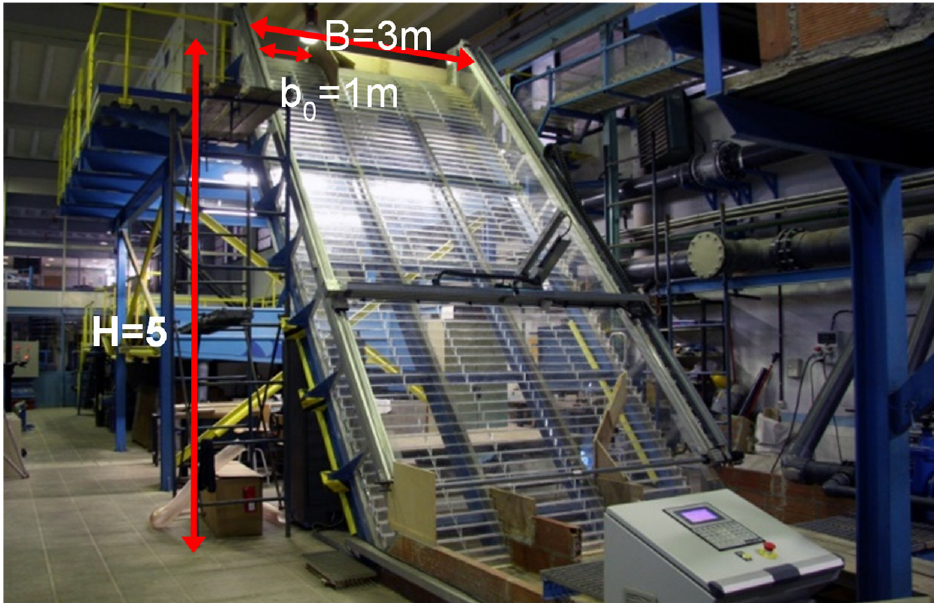
Figure 1. Frontal view of the physical model built in the Hydraulics and Fluid Mechanics Laboratory of the Civil Engineering School at UPC.